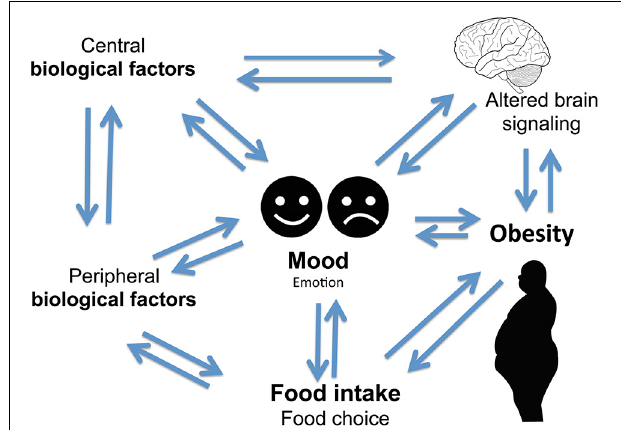
FIGURE 1 | Complex two-way relationship linking food intake, mood, and